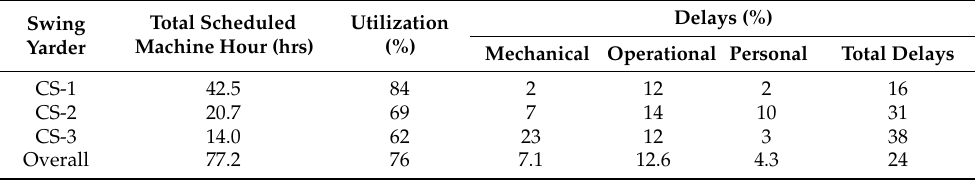
Table 5. Productive utilization for the three swing yarders